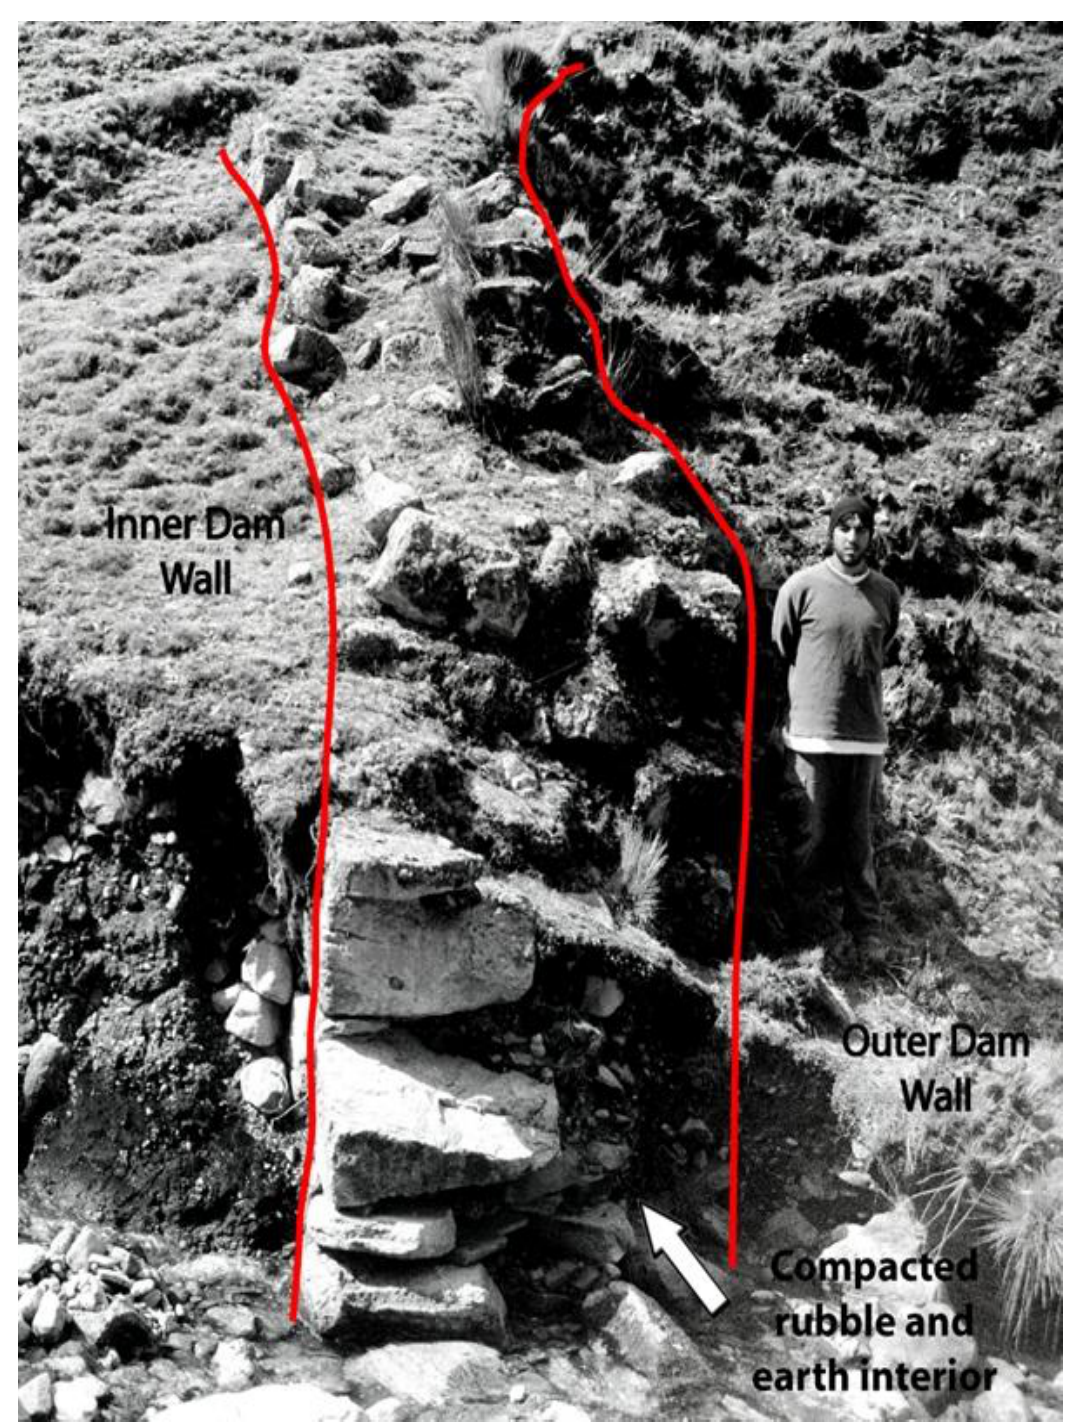
Figure 6. Profile of the Estanque Dam [Ti 1] showing the inner and outer stone walls, including the central soil and stone infill.